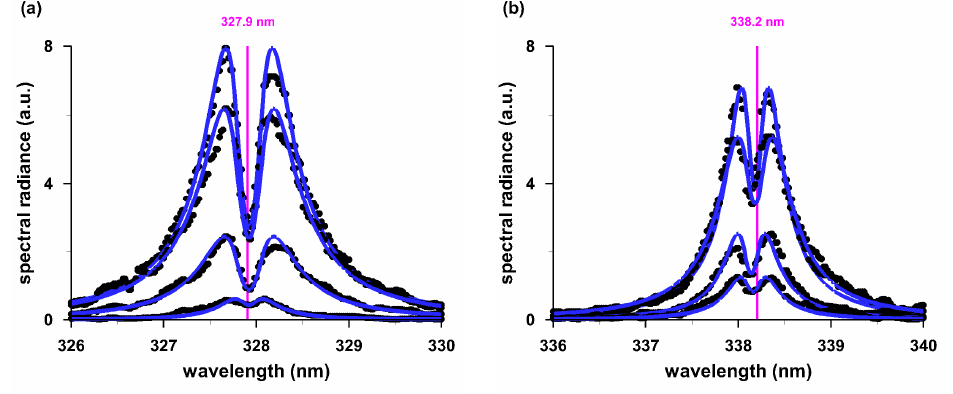
Figure 3. AgI ( a ) 327.9 nm and ( b ) 338.2 nm lines, 355-nm excitation, fluences of 13.5, 9.6, 5 and 2.1 J/cm 2 .